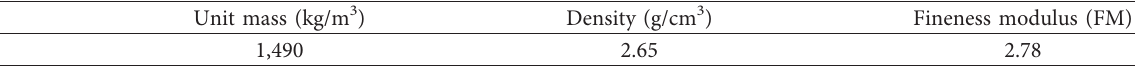
Table 2: Physical properties of fine aggregate.